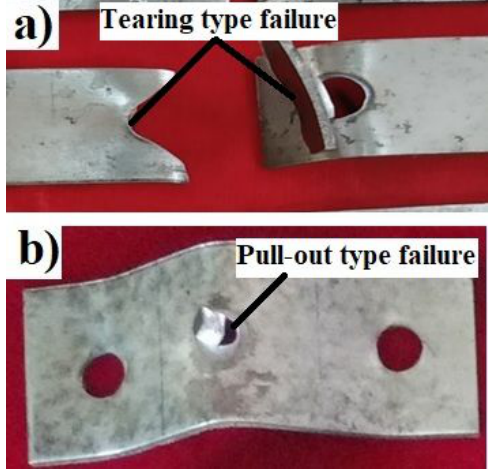
Figure 4: Failure of optimized joint of RSW AHSS-DP800: a) SL-TSFL and b) CL-TSFL specimen